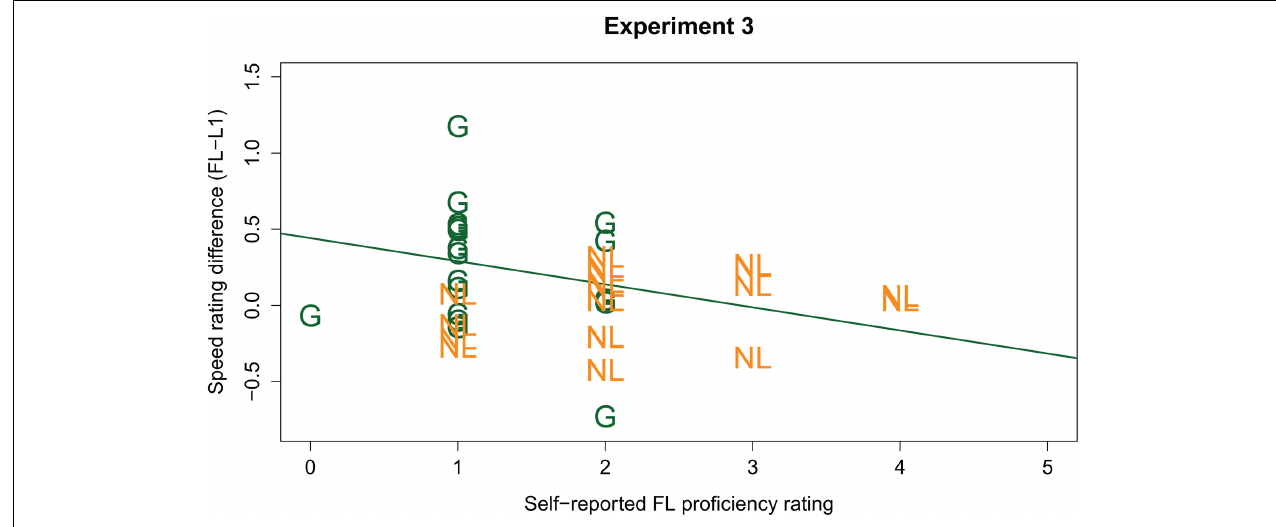
FIGURE 6 | Individual participants’ FL effect (y-axis; calculated as FL speed ratings minus L1 ratings; positive values indicate a higher speed rating in the FL) plotted against individual participants’ self-reported FL knowledge (x-axis). German participants are indicated by green “G”; Dutch participants by orange “NL.” The green line gives the regression line for the German